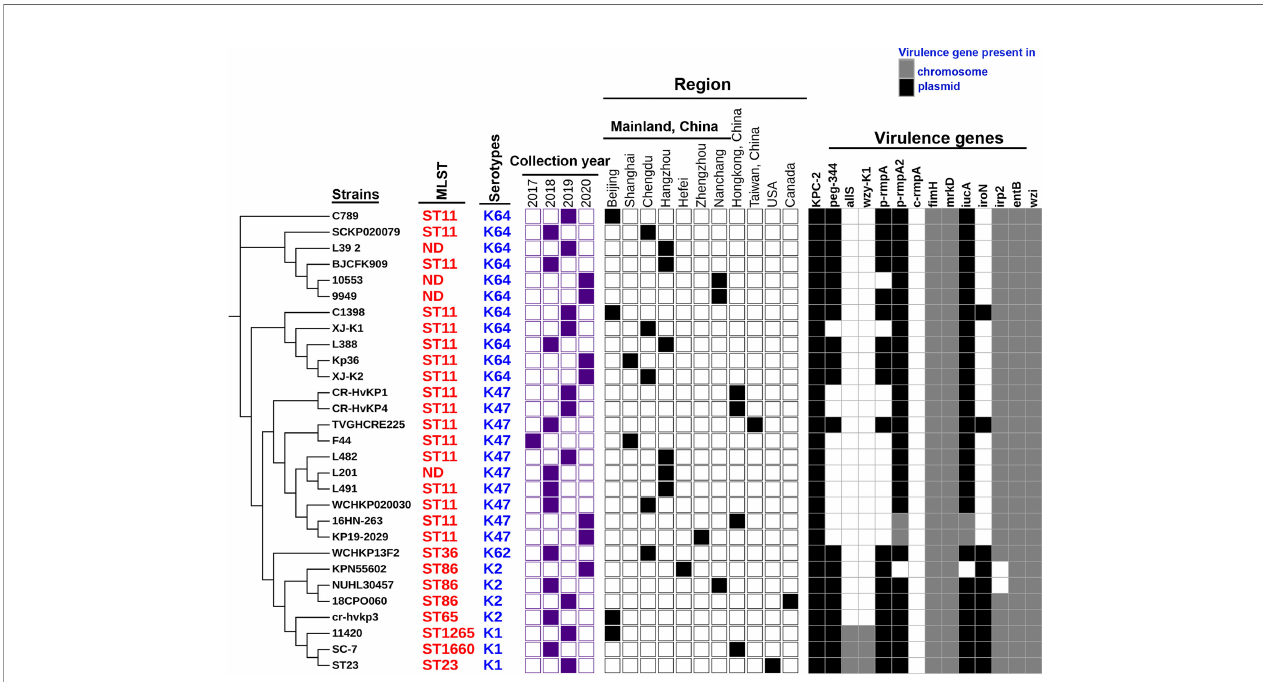
FIGURE 7 | Characteristics of the 29 Hv- bla KPC (+)-KP strains. The phylogenetic relationship of the 29 Hv- bla KPC (+)-KP strains was analyzed by kSNP 3.0 Based on the predicted results, the binary gene presence/absence matrix was created re fl ecting the collection year, collection region, bla KPC-2 gene and core virulence genes. The STs of Hv- bla KPC (+)-KP strains were marked on the right of the phylogenetic tree. ND: not de fi ned. The presence of genes, etc. is represented by a solid box. and the absence of others is represented by a white